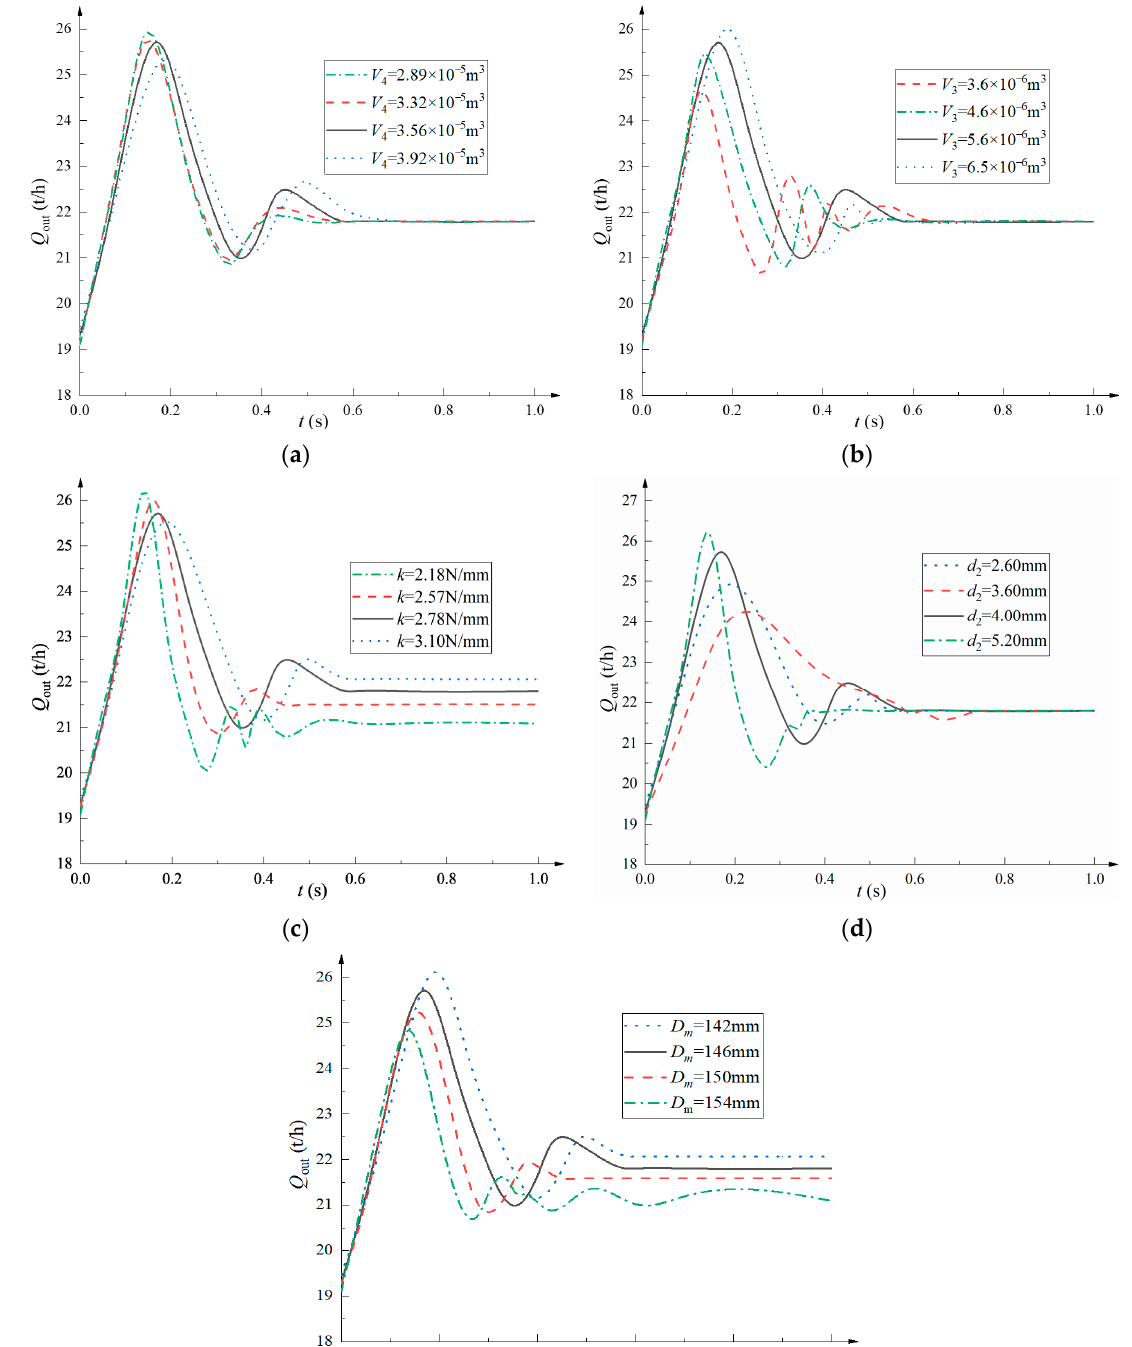
Figure 16. Flow dynamic characteristics of different structural parameter values. ( a ) Dynamic characteristic curves of different V 4 ; ( b ) dynamic characteristic curves of different V 3 ; ( c ) dynamic characteristic curves of different k ; ( d ) dynamic characteristic curves of different d 2 ; ( e ) dynamic characteristic curves of different D m .